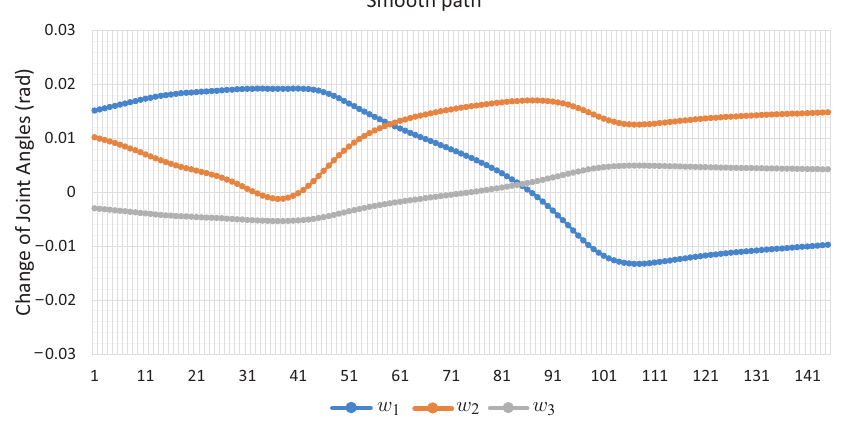
Figure 12. Change of joint angle motion of Case Study 1.